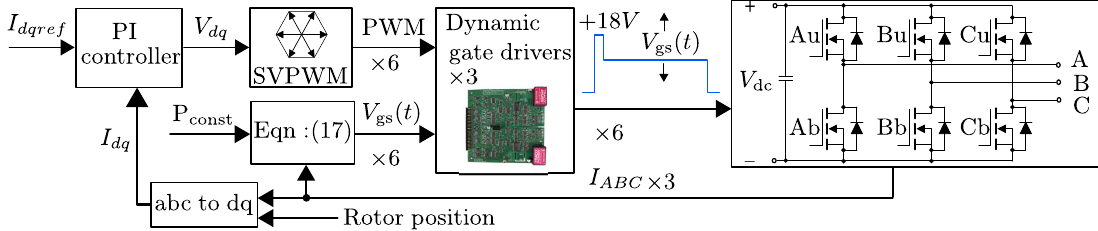
Figure 5. Operation principle of the gate voltage control in the electric motor drive